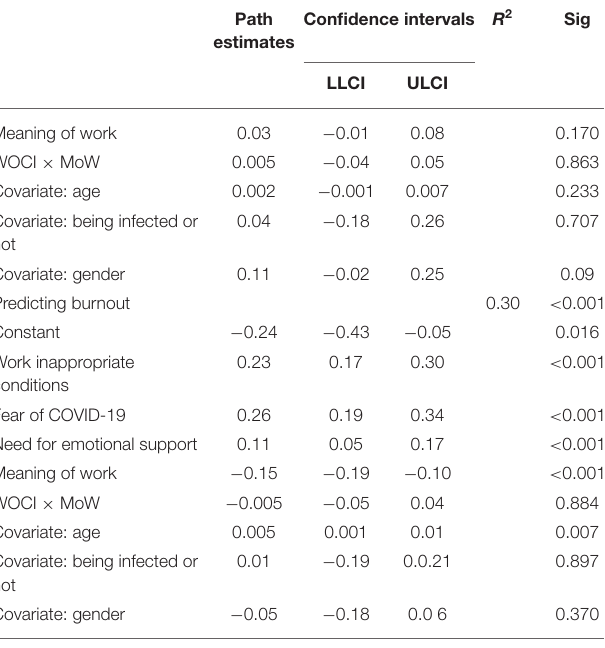
TABLE 2 | Path estimates (unstandardized coefficients) for the mediation analyses.